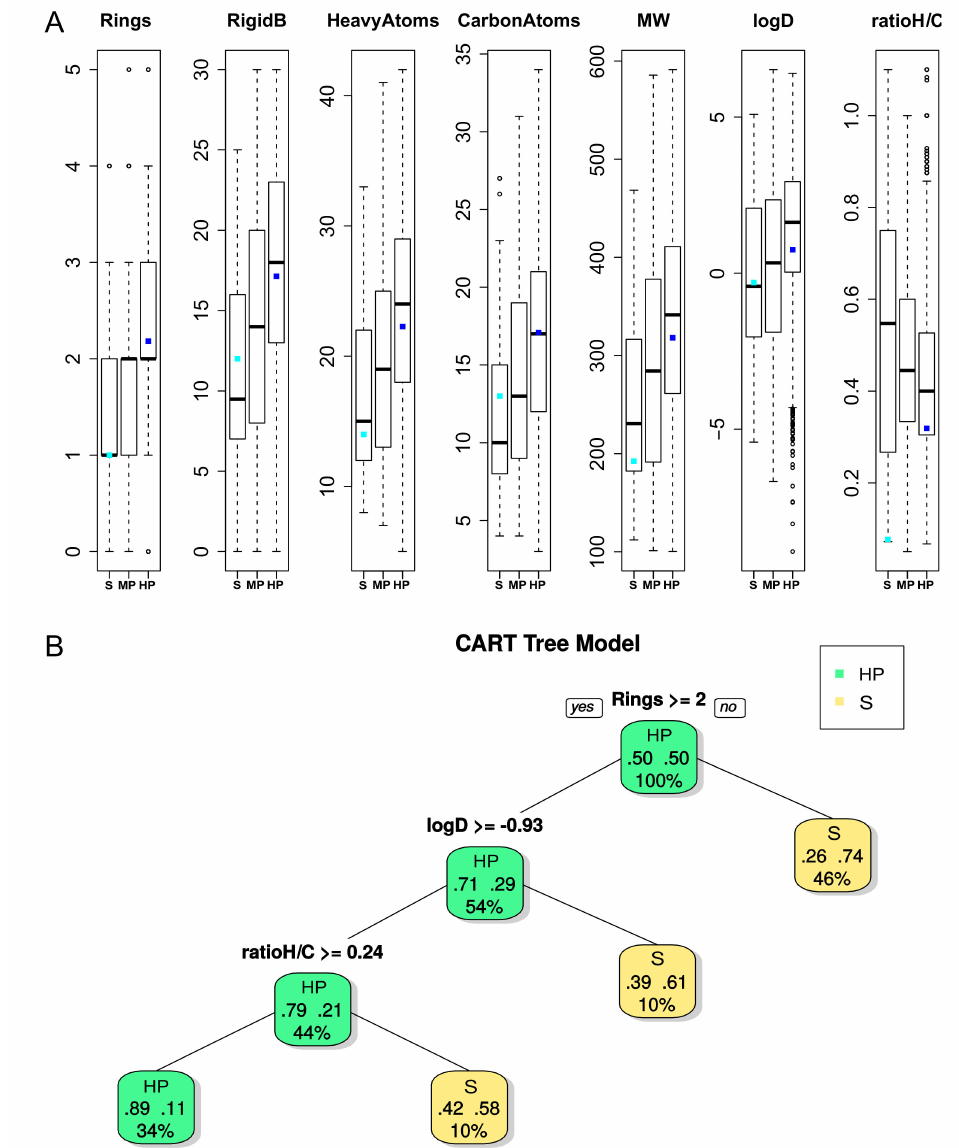
Figure4. ( A )Boxplotofsevenligandproperties( p -value < 3 × 10 − 10 exceptfortheratiobetweenhydrogen and carbon atoms called ratioH / C, p -value = 0.1) from ligands associated with the Ligand–Cluster dedicated to S or HP DBS. For each boxplot, the black bar in the rectangle represents the medium, and the upper side is the third quartile and the lower side is the first quartile of data. The dashed lines represent values below the first quartile limit and values above the third quartile limit. Circles represent atypical values; the cyan dot and the blue dot represent the values of the ligand in interaction with a lyase selective DBS (PDB 4KVI) and an Urokinase HP DBS (PDB 1F5K), respectively, as illustrated in Figure 5. ( B ) Representation of the CART tree for ligands based on ligand descriptors between S (yellow) and HP (green) ligands. Each node is described by the class (promiscuity), the probability per class (right = HP and left = S), and the percentage of observations in the node. The CART model provided an average accuracy, sensitivity, and specificity of 77%, 67%, and 77% for the test set (53 versus 2,621 ligands), respectively, and 72% ± 3%, 69% ± 7%, and 73% ± 3% while using a five-fold cross validation on the training set (500 runs),